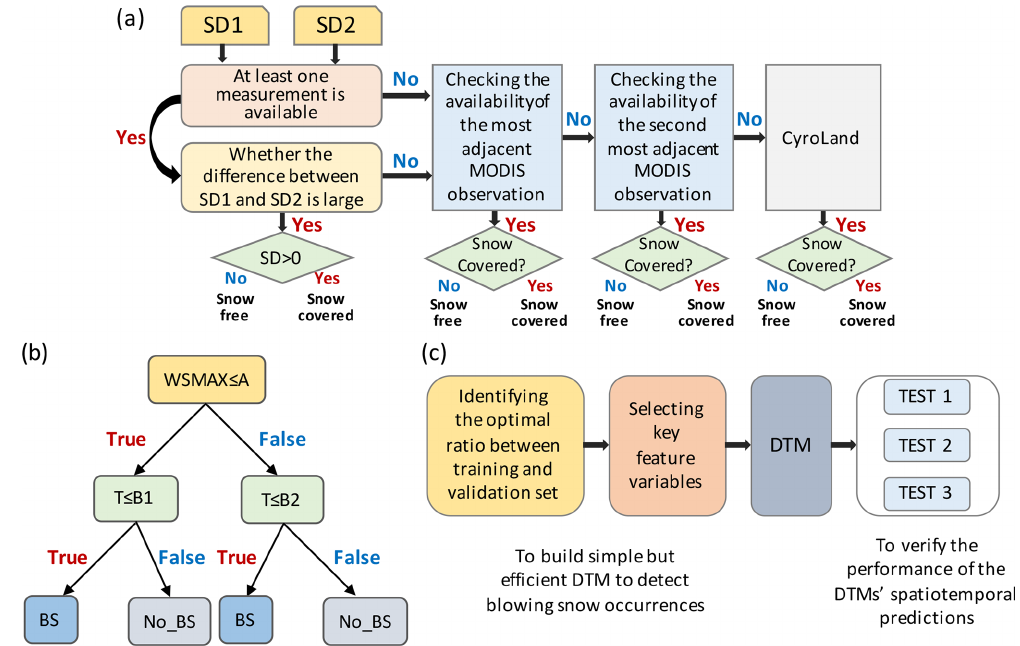
Figure 1. Schematic flowchart of (a) the procedures to identify the presence of snow, (b) flowchart of a simple decision tree model to detect blowing snow occurrence (only WSMAX and T were used to construct the DTM, A denotes the threshold maximum wind speed, and B 1 and B 2 denote the threshold air temperature), and (c) logical framework of this study. BS and No_BS denote with and without blowing snow occurrence, respectively.